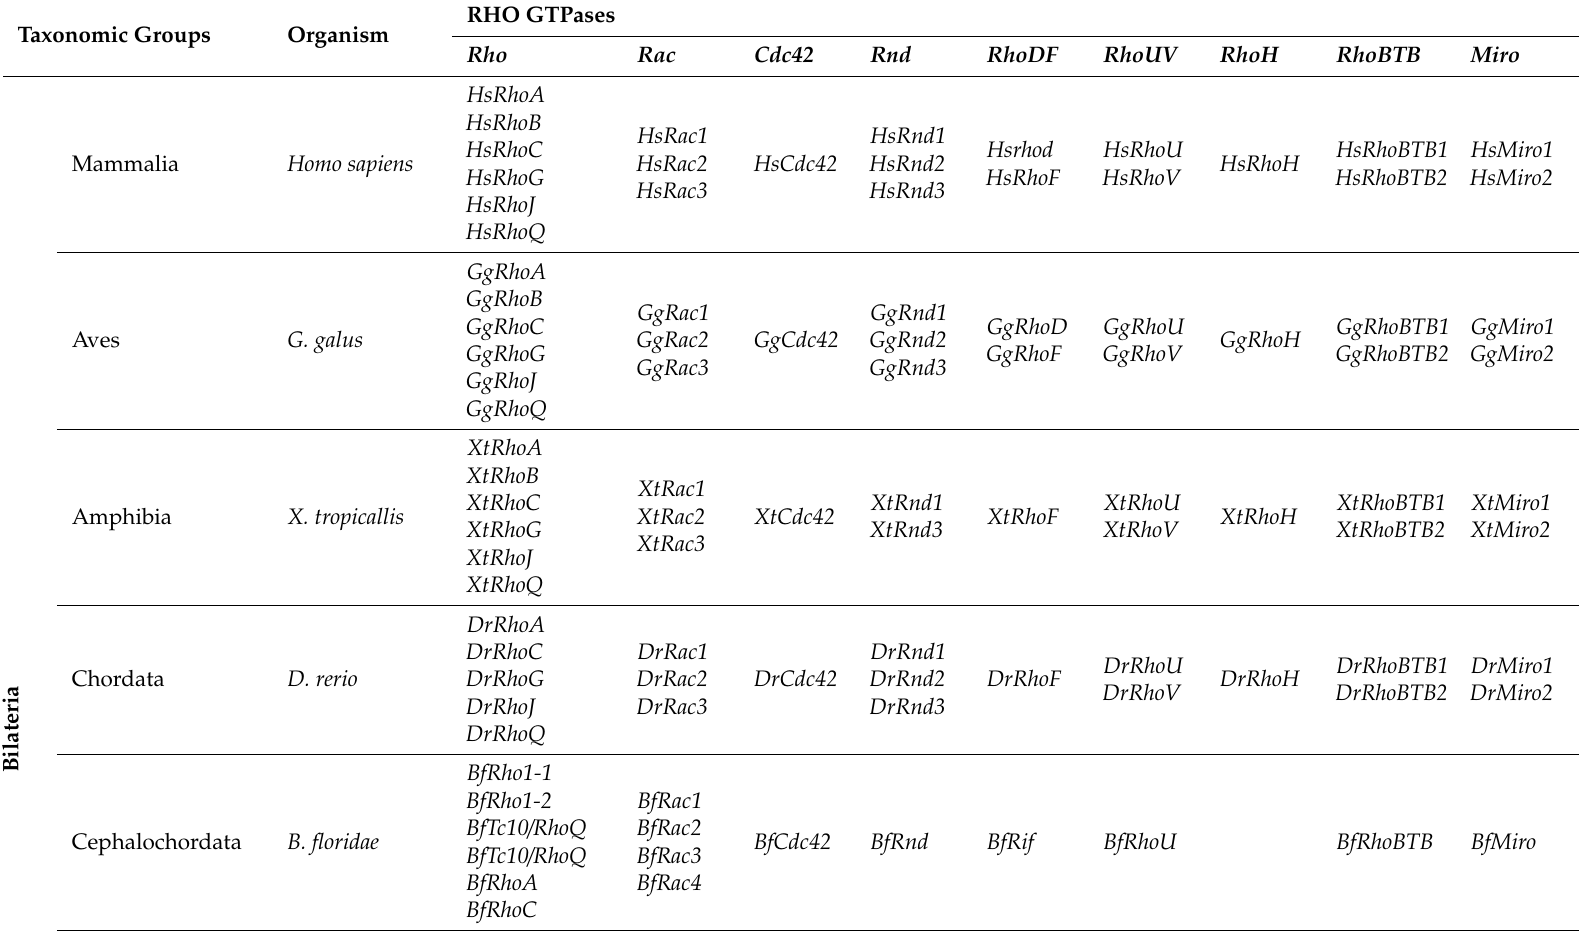
Table 1. Rho GTPases in Metazoa and close unicellular relative of